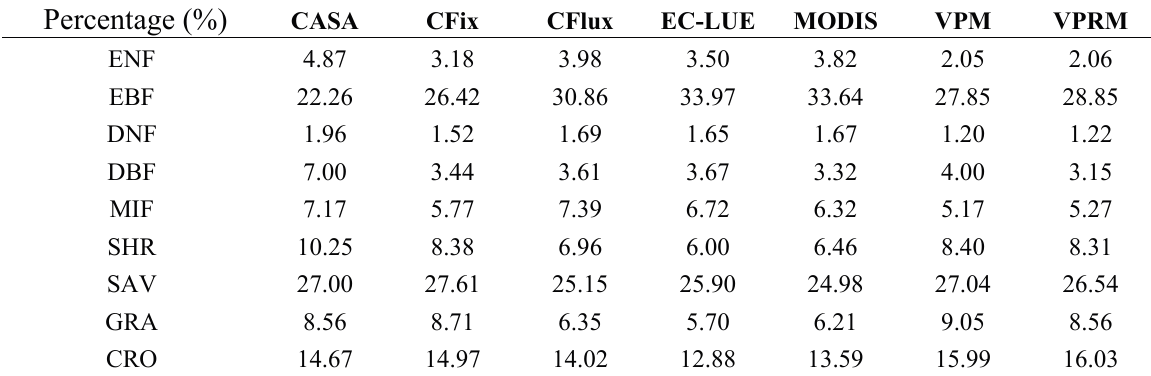
Table 2. Percentage of the GPP estimates of various vegetation types to the global GPP. Percentage (%) CASA CFix CFlux EC-LUE MODIS VPM VPRM ENF 4.87 3.18 3.98 3.50 3.82 2.05 2.06 EBF 22.26 26.42 30.86 33.97 33.64 27.85 28.85 DNF 1.96 1.52 1.69 1.65 1.67 1.20 1.22 DBF 7.00 3.44 3.61 3.67 3.32 4.00 3.15 MIF 7.17 5.77 7.39 6.72 6.32 5.17 5.27 SHR 10.25 8.38 6.96 6.00 6.46 8.40 8.31 SAV 27.00 27.61 25.15 25.90 24.98 27.04 26.54 GRA 8.56 8.71 6.35 5.70 6.21 9.05 8.56 CRO 14.67 14.97 14.02 12.88 13.59 15.99